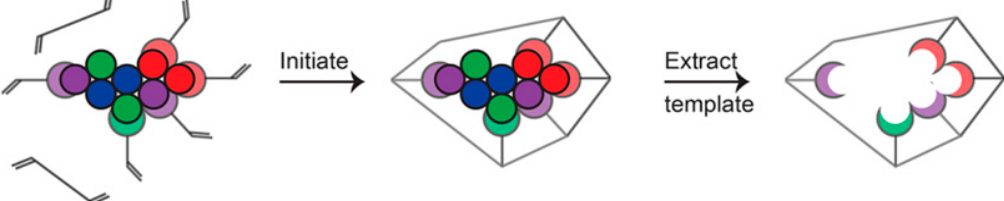
Figure 1. Illustration schematic of the preparation principle of molecularly imprinted polymers (MIPs). Reprinted with permission from [40], copyright (2017) American Chemical Society.